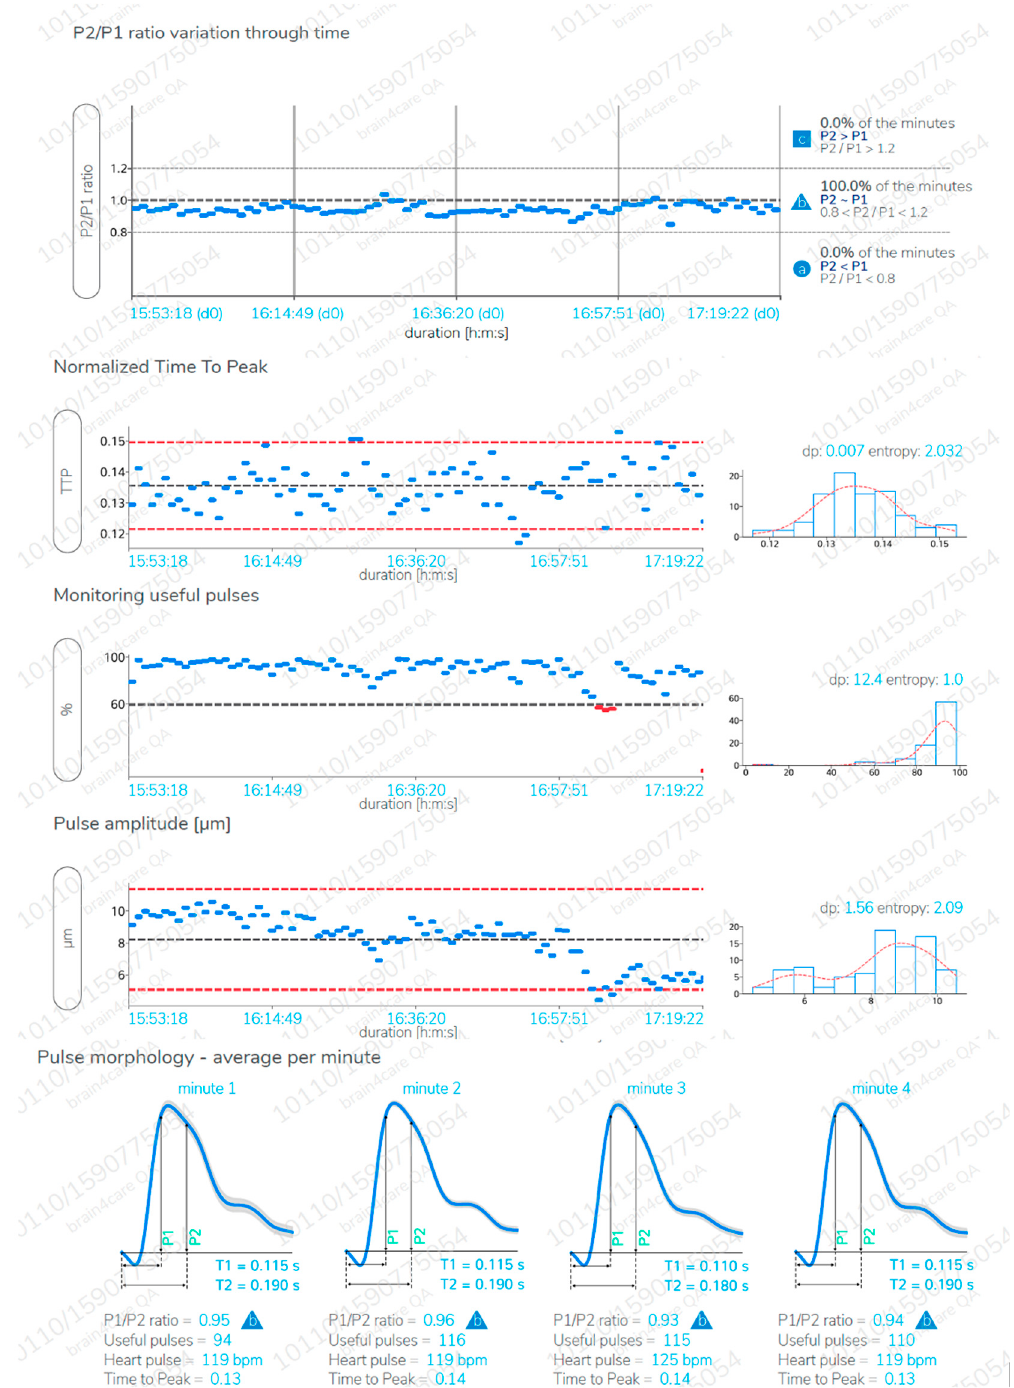
Figure 3. A B4C monitoring report sample of more than an hour length. Real time report is obtained without monitoring interruption as needed. P2/P1 ratio, time to peak, pulse amplitudes and useful pulses (pulses that were successfully recognized) are disclosed for the entire monitoring (each blue point is the mean value for a minute) and a mean waveform with confidence interval (gray zone along the slope) of each monitored minute is also displayed (bottom).